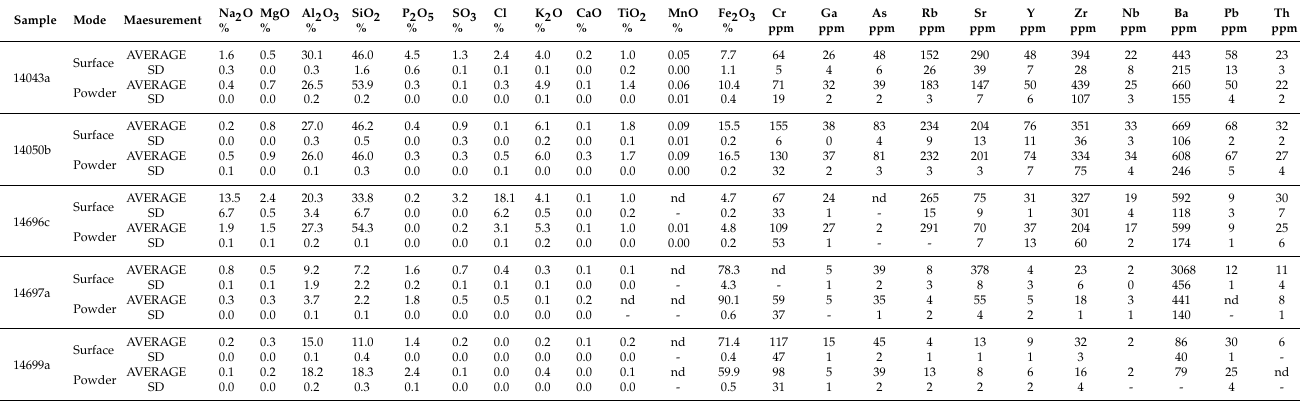
Legend—nd: not detected.